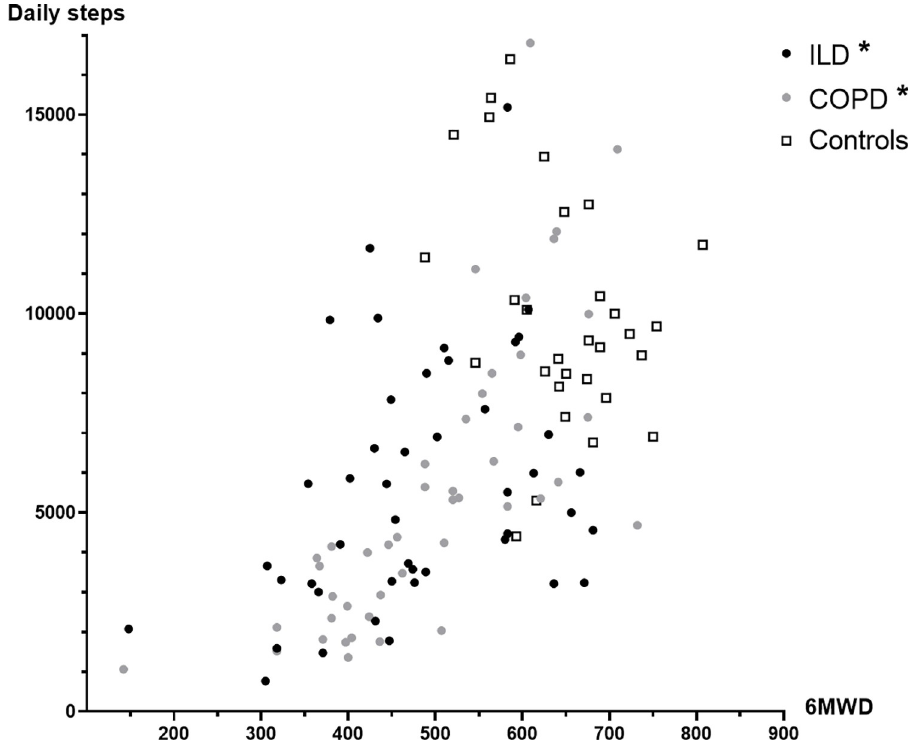
Fig 3. Correlation between functional exercise capacity and physical activity in patients with ILD, COPD and healthy controls. Correlation between six-minute walking distance (x-axis) and daily steps (y-axis) in patients with ILD (black dots), COPD (grey dots) and healthy controls (open squares). � P <